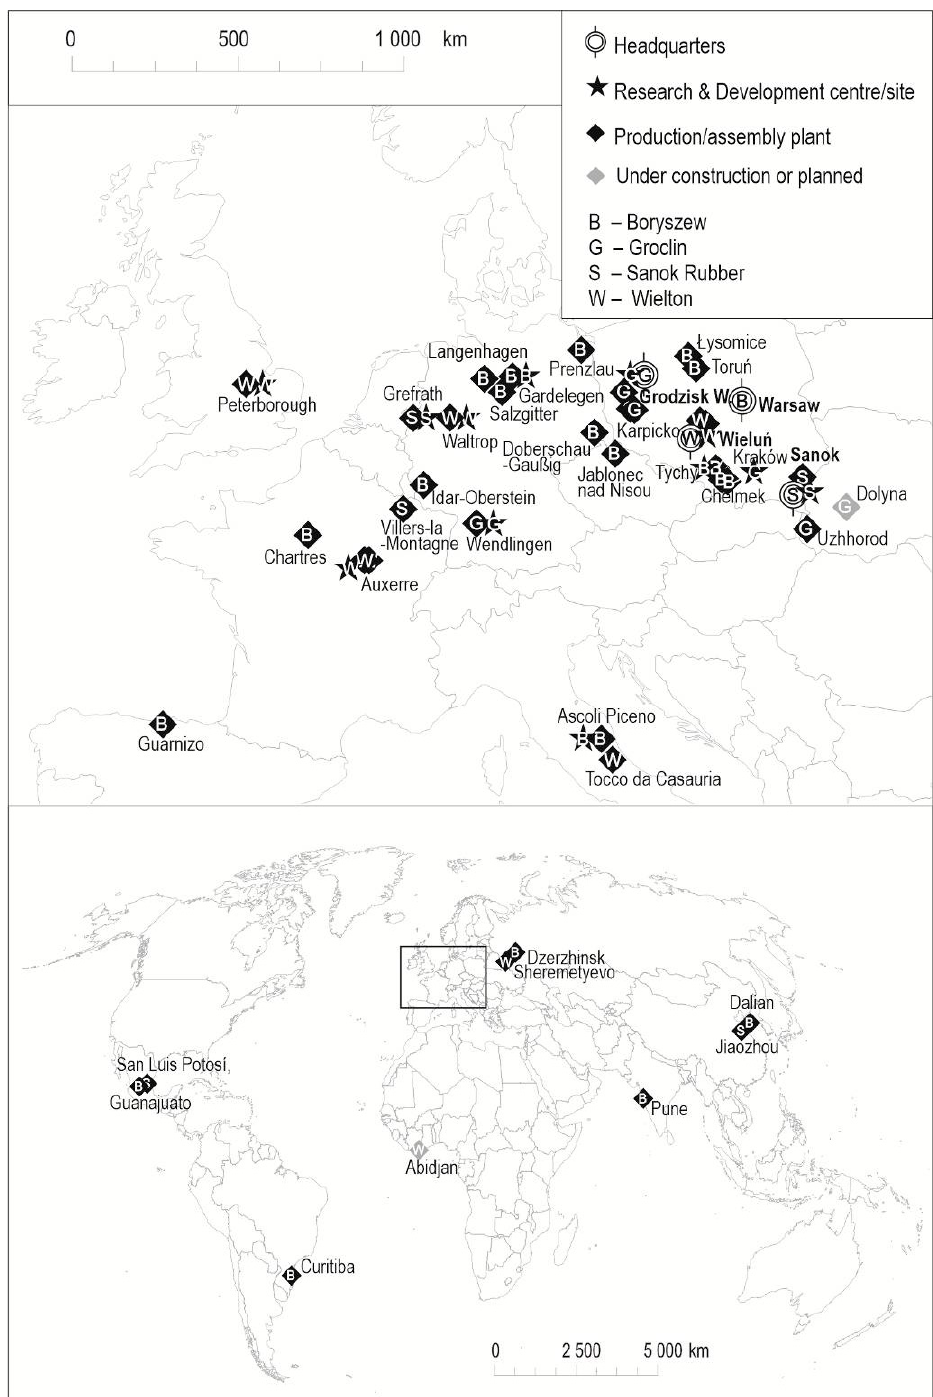
Figure 3. Automotive factories and R&D centers of Wielton, Boryszew, Sanok Rubber, and Groclin. Source: authors’ elaboration based on annual company reports of analyzed companies.